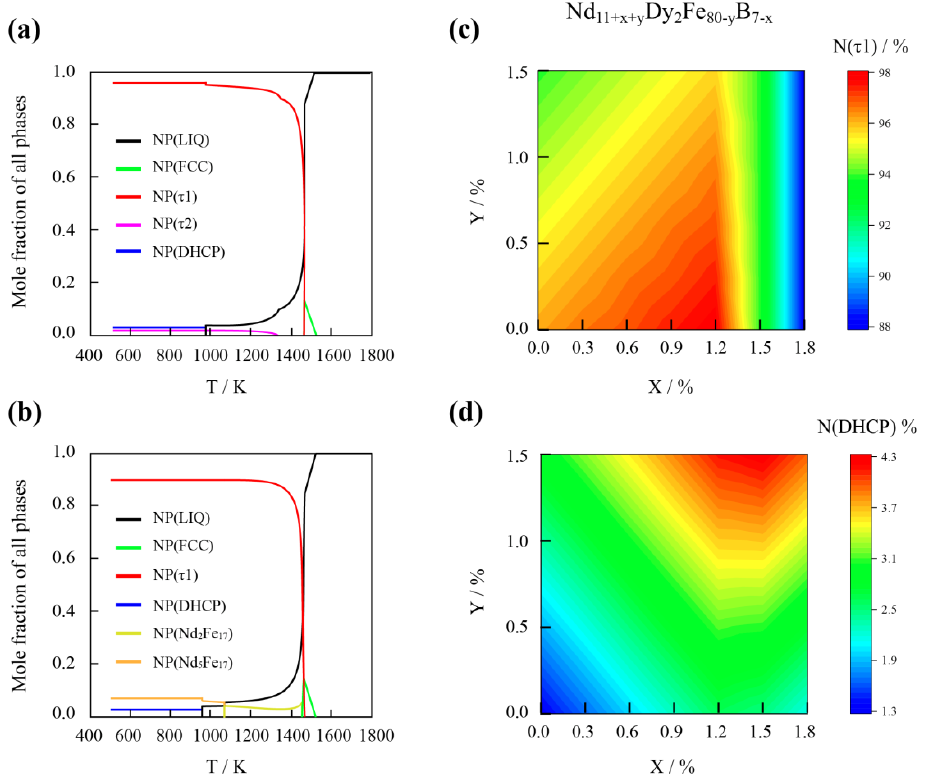
Figure 2. Compositional distributions of τ 1 and DHCP phases. Calculated equilibrium continuous cooling diagrams of ( a ) Nd 12 Dy 2 Fe 80 B 6 and ( b ) Nd 13 Dy 2 Fe 79 . 7 B 5 . 3 . Mole fraction distributions of ( c ) τ